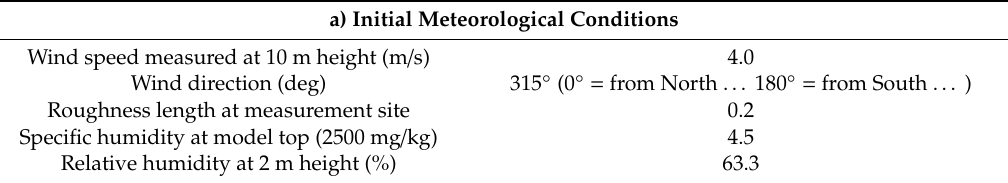
Table 6. Input configuration data applied in the models to run the ENVI-met simulations.